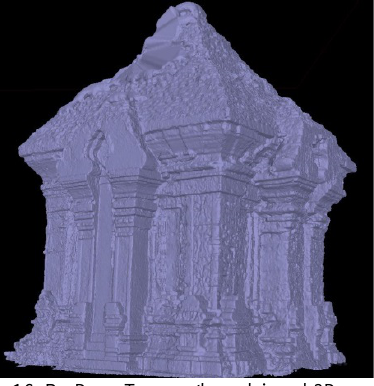
Figure 16. Po Dam Tower, the achieved 3D mesh by Photoscan Agisoft